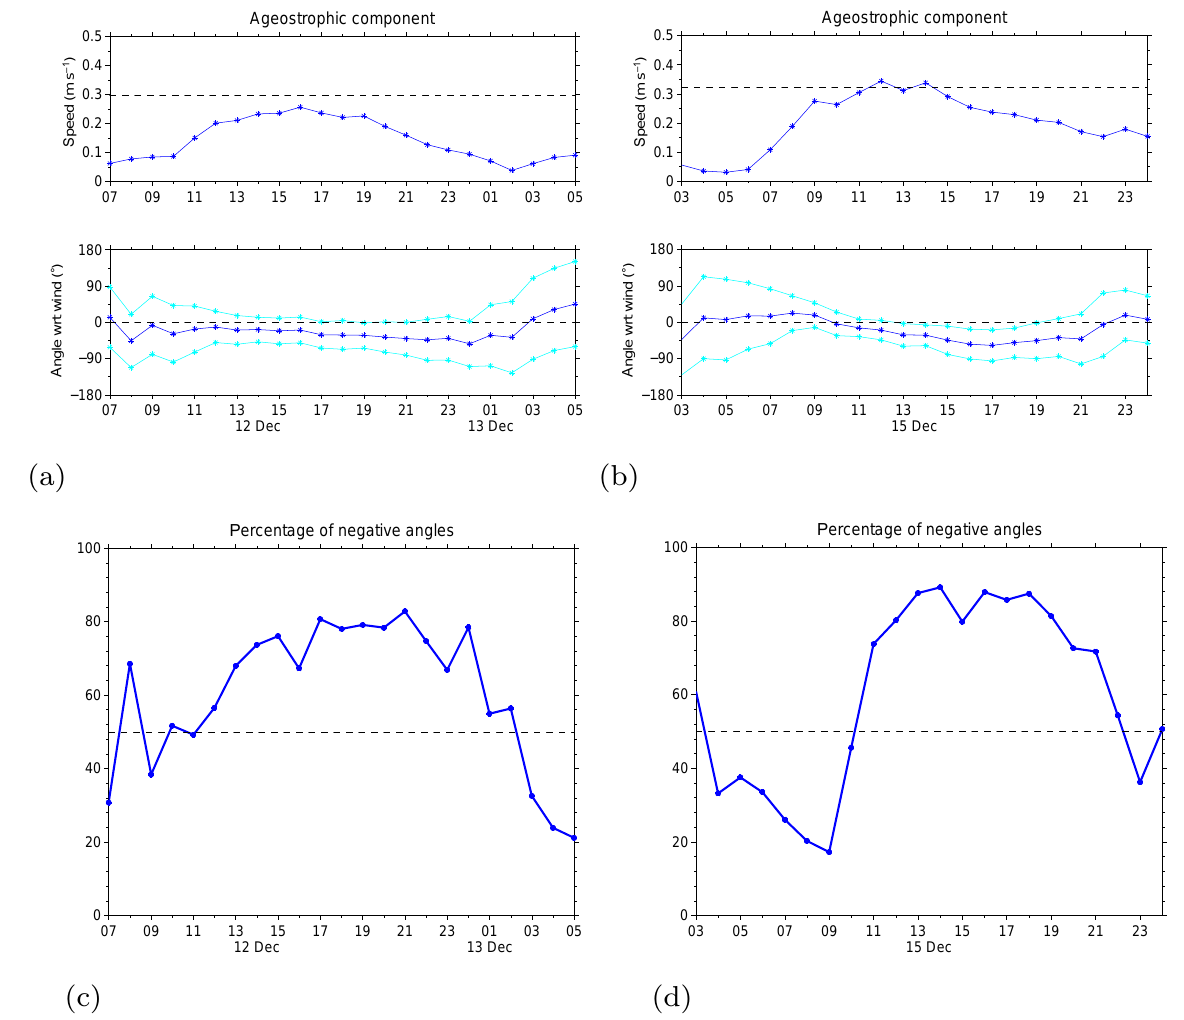
Figure 12. (a, b) Time series of the spatially averaged ageostrophic component (cid:91) u SaW magnitude (top panels) and angle α(t) (middle panels) with respect to the wind direction (negative angle indicates currents to the right of the wind). The cyan lines in the bottom panels represent the SD. The black dashed lines in the top panels represent the average magnitude of the geostrophic component d u Sg , while the black dashed lines in the middle panels indicate 0 ◦ angles. (c, d) Time series of the percentage of negative angles α (between ageostrophic component and wind) distributed over the HFR coverage. The black dashed lines in the bottom panels indicate